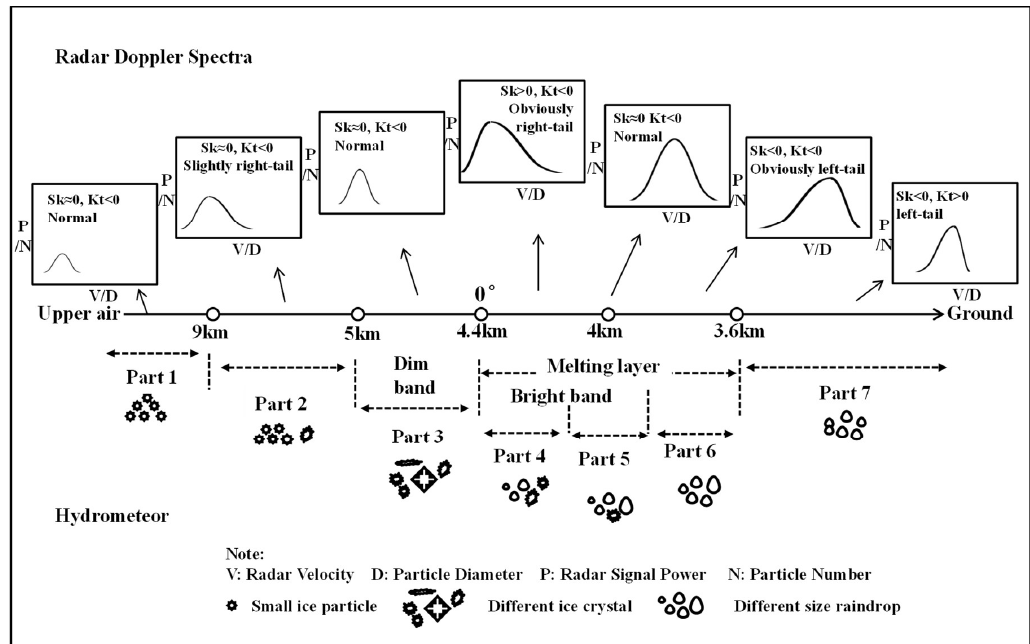
Figure 7. Forward pattern of the Ka-band MMCR Doppler spectra for seven different height ranges in the multi-cell convection.